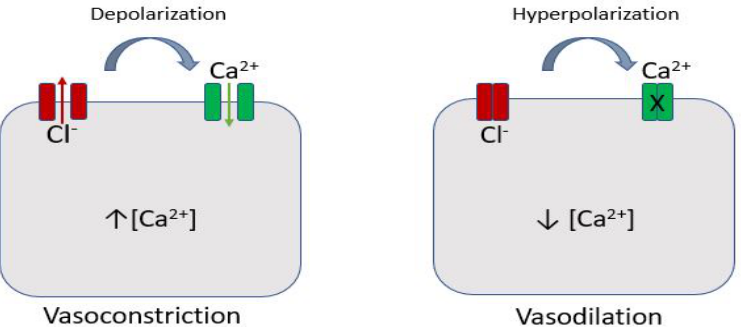
Figure 2. Cl − channels and vascular tone. Chloride channels are expressed in the vascular smooth muscle cells: by opening these channels, Cl − ions move out of the cells and, depolarizing them, determine Ca 2+ inflow with a consequent vasoconstriction effect; the opposite occurs when they are closing. Cl − : Chloride.